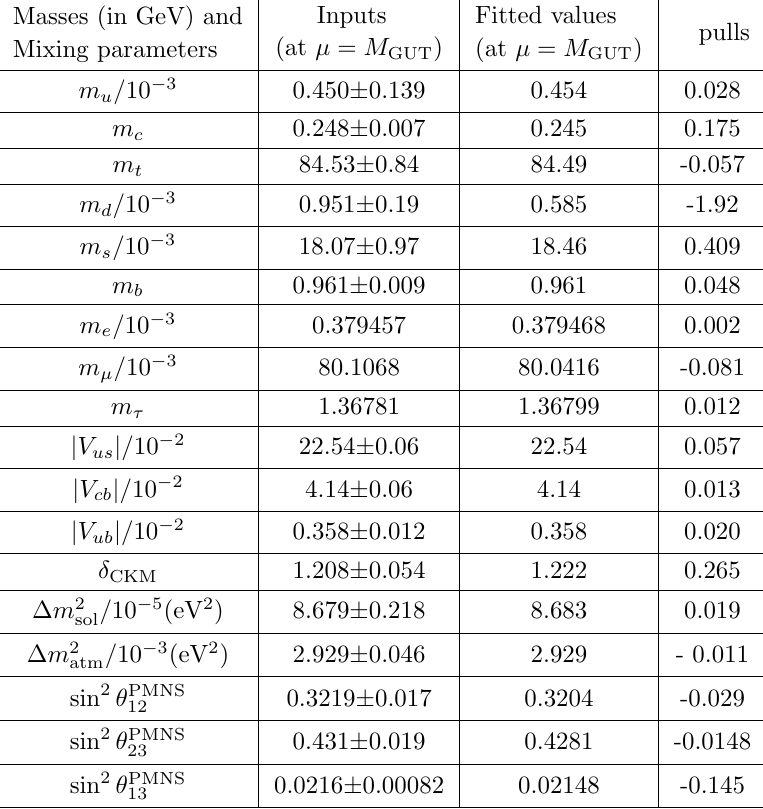
Table 2 . Best (cid:12)t values of the observables corresponding to the type-I dominance seesaw scenarios is presented. This best (cid:12)t corresponds to total (cid:31) 2 = 4. The values of the observables at the GUT scale are obtained by RGE evolution as explained detail in the text. We have chosen M GUT = 2 10 16 GeV, g B = 0 : 708 and we have (cid:12)xed tan (cid:12) = 10 for this numerical analysis. For (cid:2)